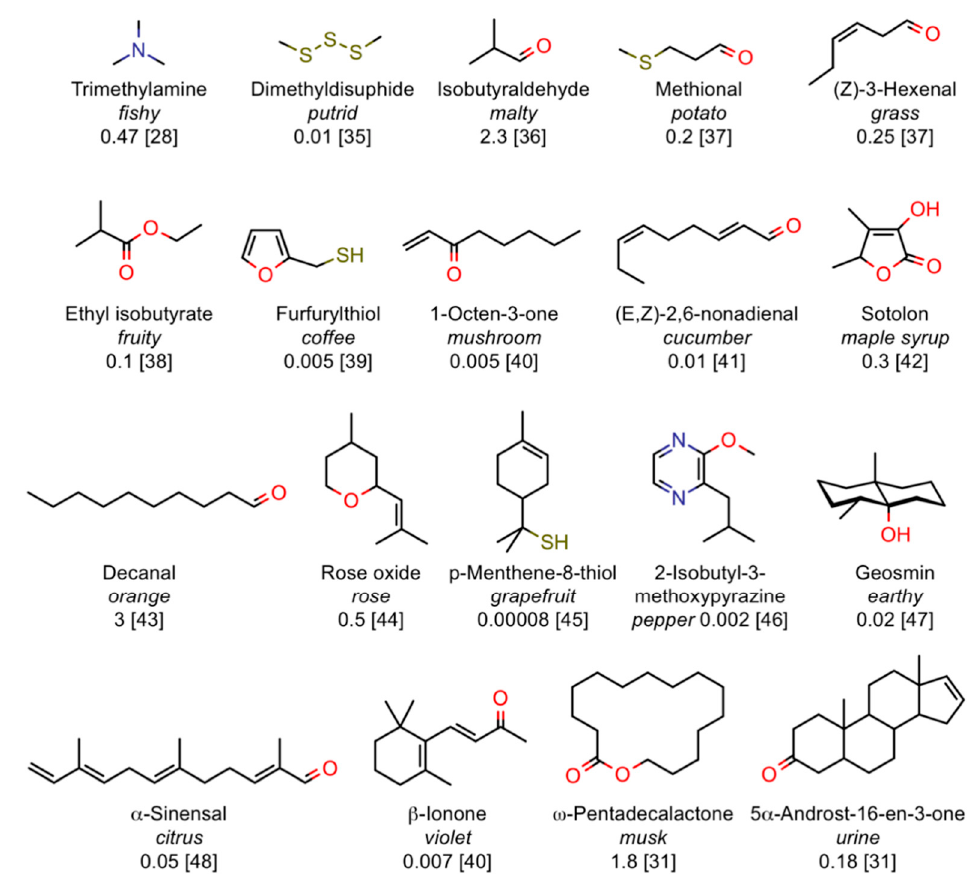
Figure 3. Examples of volatile compounds with extremely low olfactory thresholds for humans. Together with names and structures, odour description is reported in italics, olfactory thresholds in ppb (parts per billion) and reference in parenthesis. The olfactory threshold values are given as an indication as differences by one order of magnitude are often found between published works. Moreover, sensitivity to each specific odorant can span two orders of magnitude across the human population.